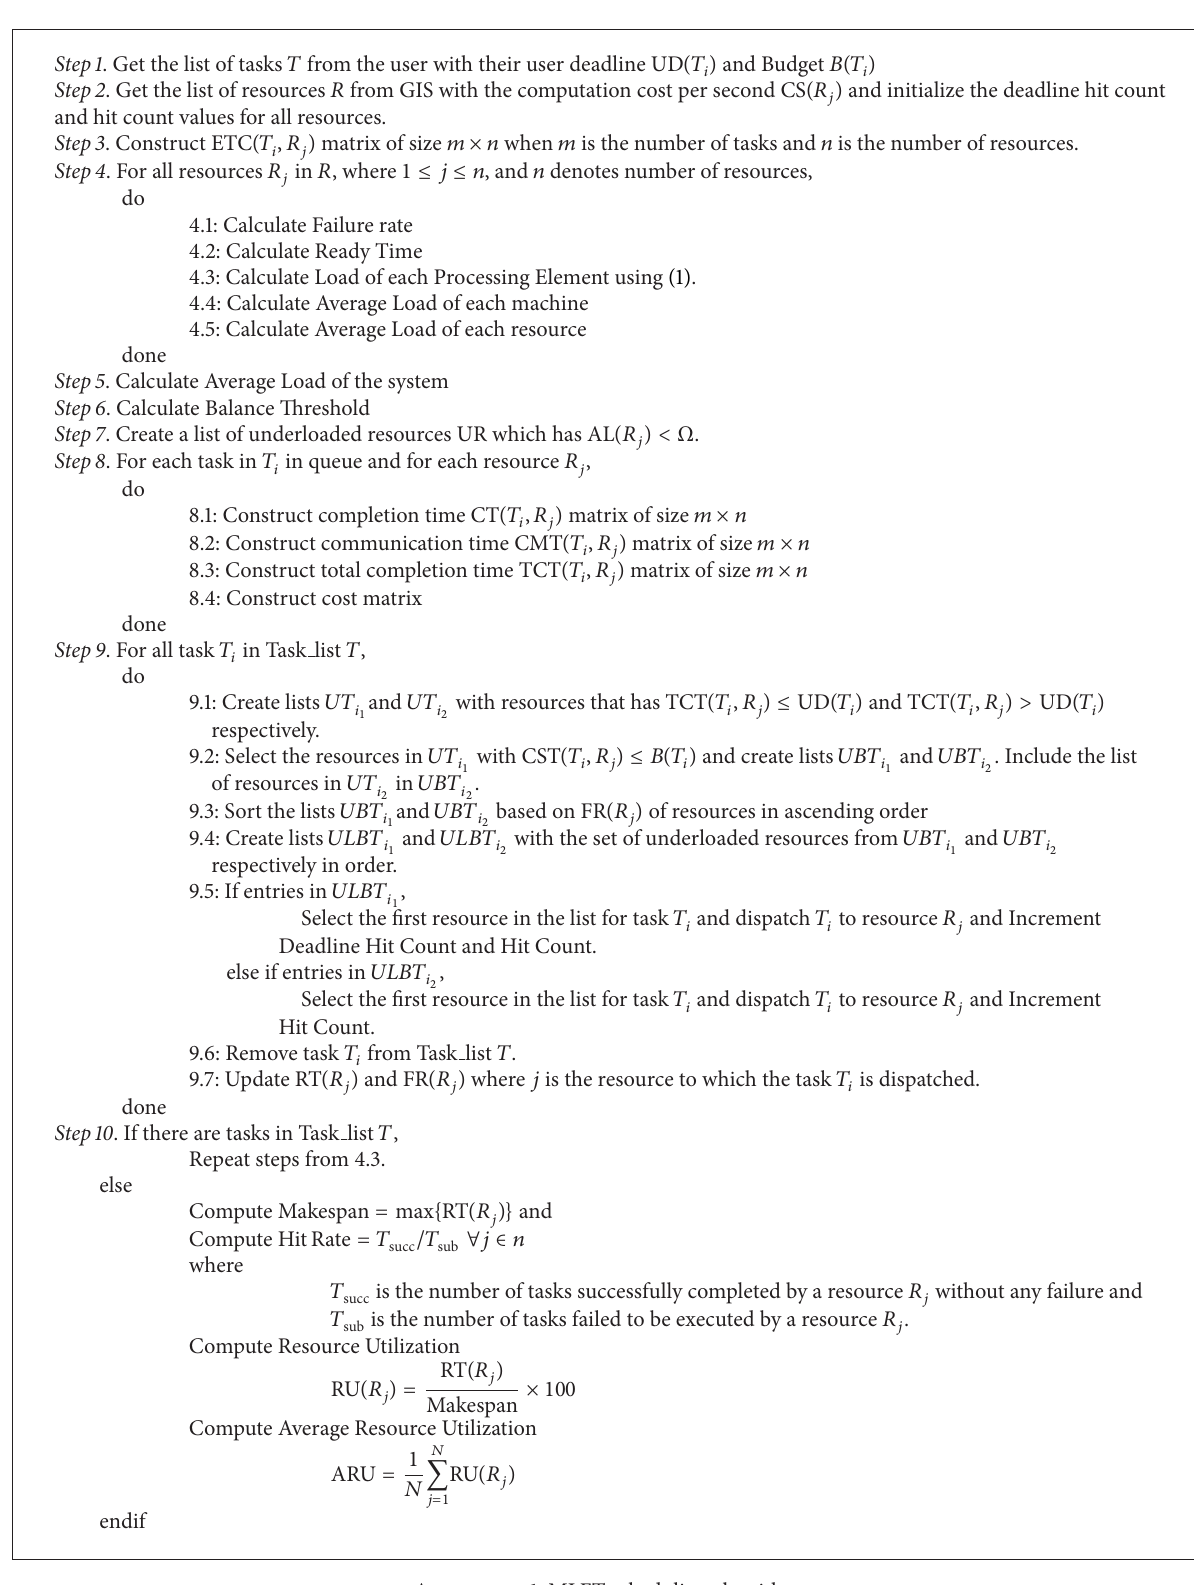
Algorithm 1: MLFT scheduling